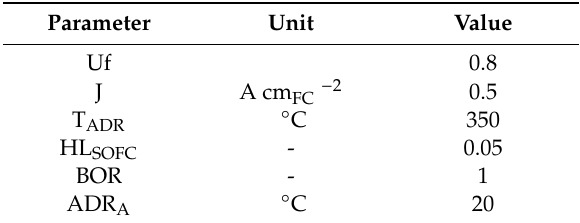
Table 9. Inputs values of system nominal